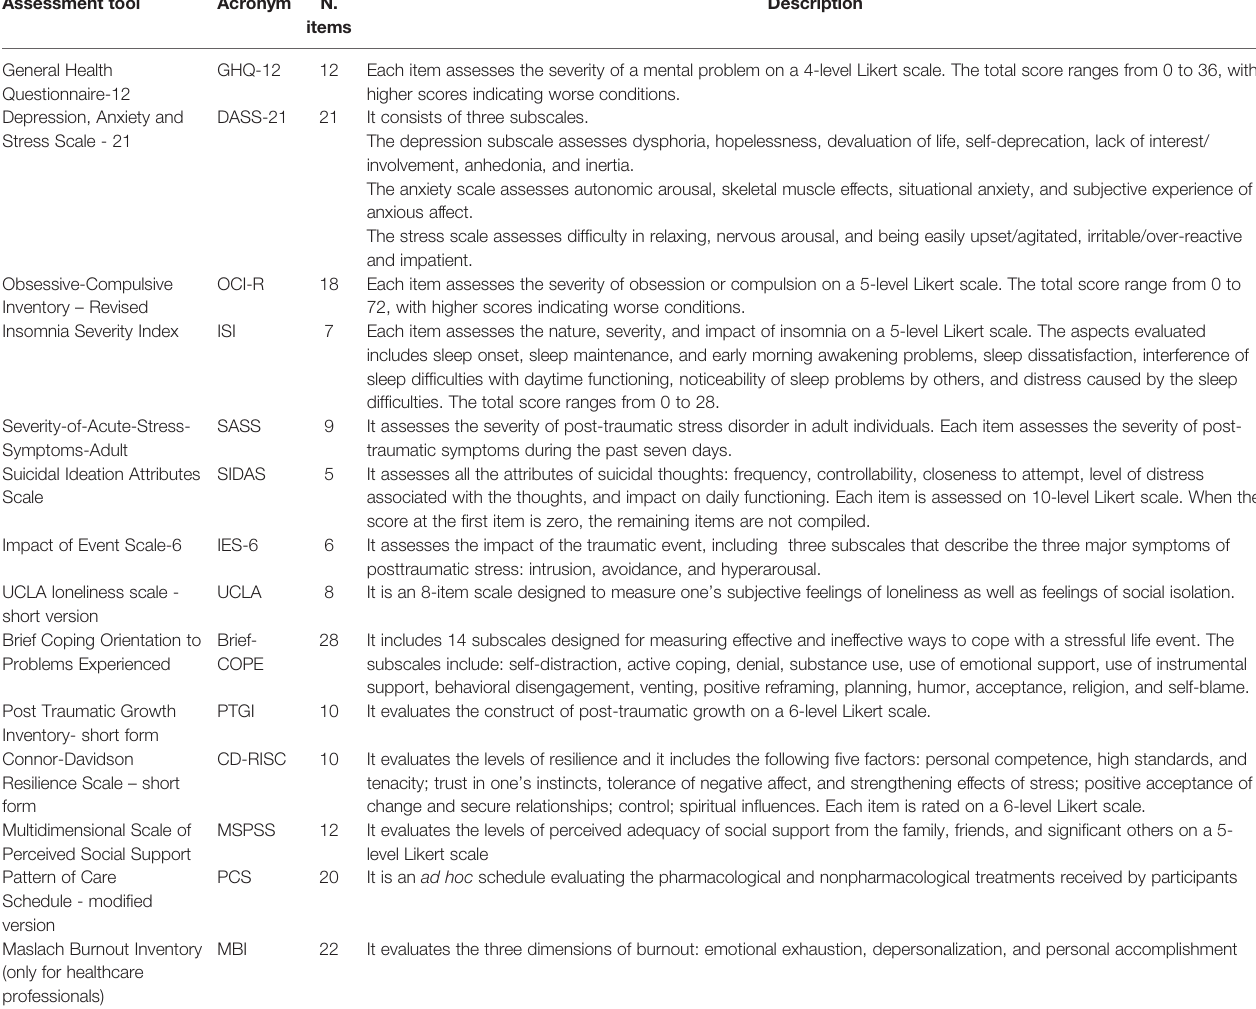
TABLE 1 | Assessment tools used in the